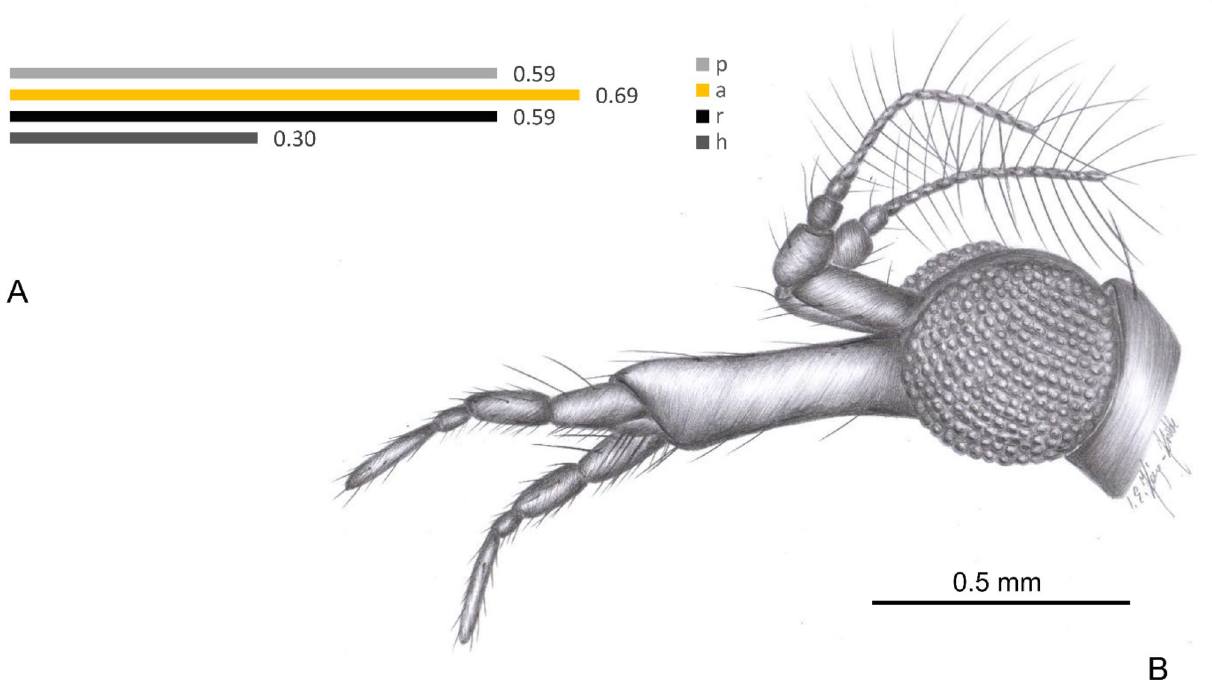
of head (h): as in Fig.